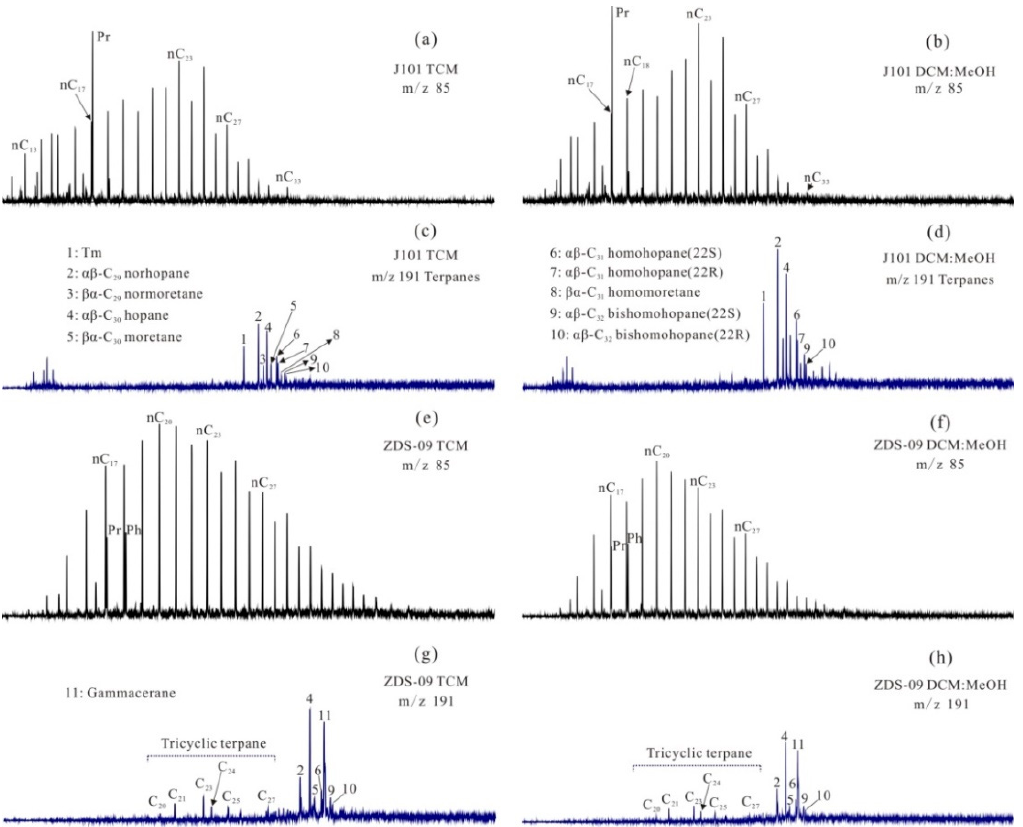
Figure 3. Gas chromatogram of saturated hydrocarbons in extracts from typical samples with different solvents (m/z 85 and m/z 191 mass fragments of the J101 and ZDS-09 samples, respectively). ( a , c , e , g ) Treated with TCM; ( b , d , f , h ) treated with DCM: MeOH. Pristane (Pr) and phytane (Ph) are the essential acyclic isoprenoids used for evalu-